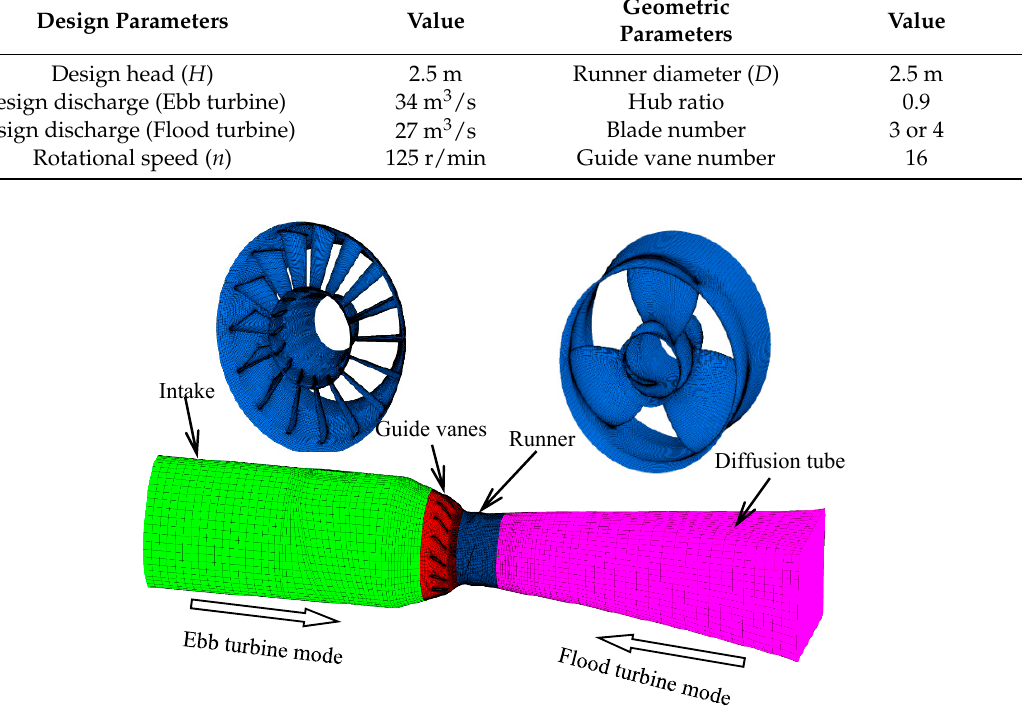
Table 1. Main parameters of the prototype unit.